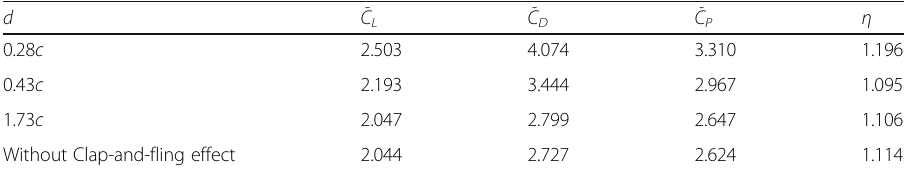
Table 4 Averaged aerodynamic coefficient and power coefficient under different wing root